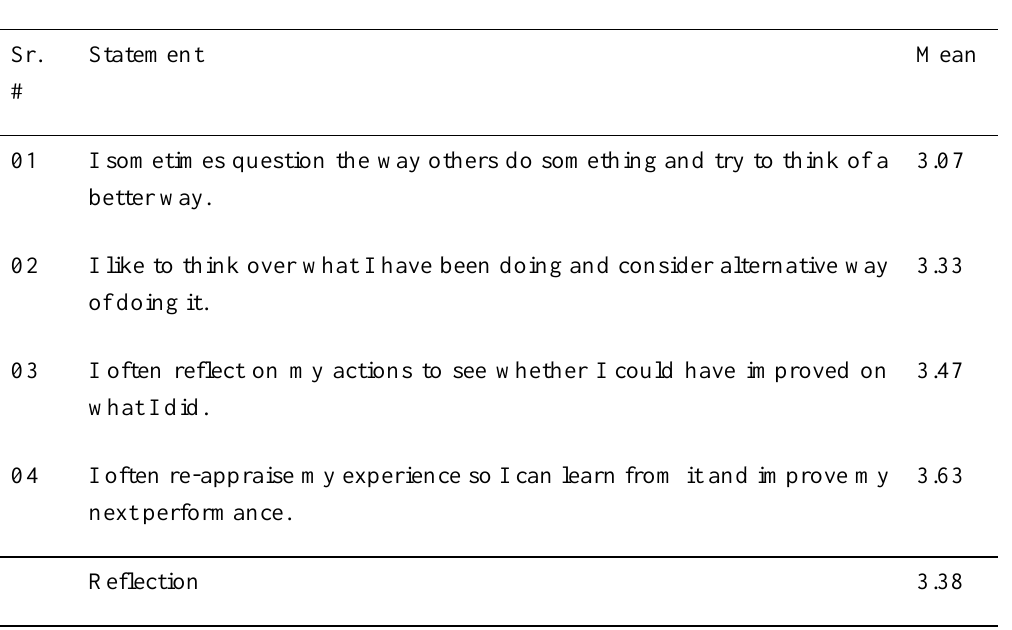
Students Thinking Practices Governed by